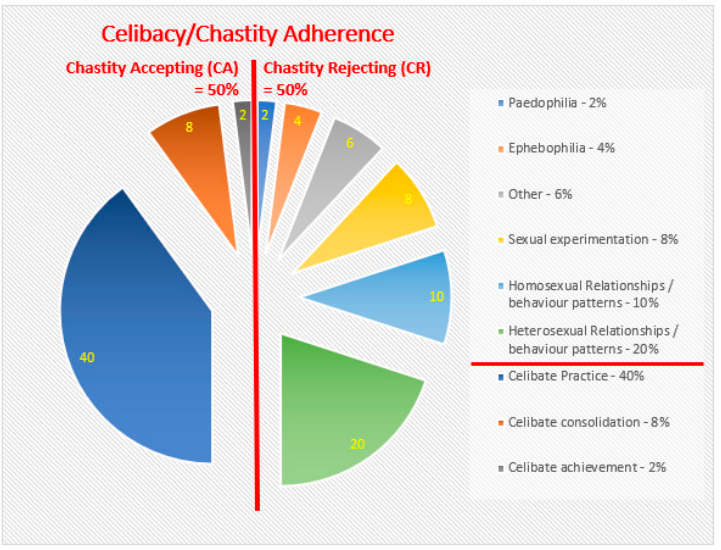
Figure 2. Sipe’s chastity/celibacy adherence levels (adapted from Sipe 1995, p.